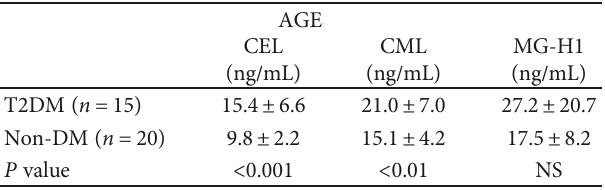
Table 3: Serum AGEs levels.